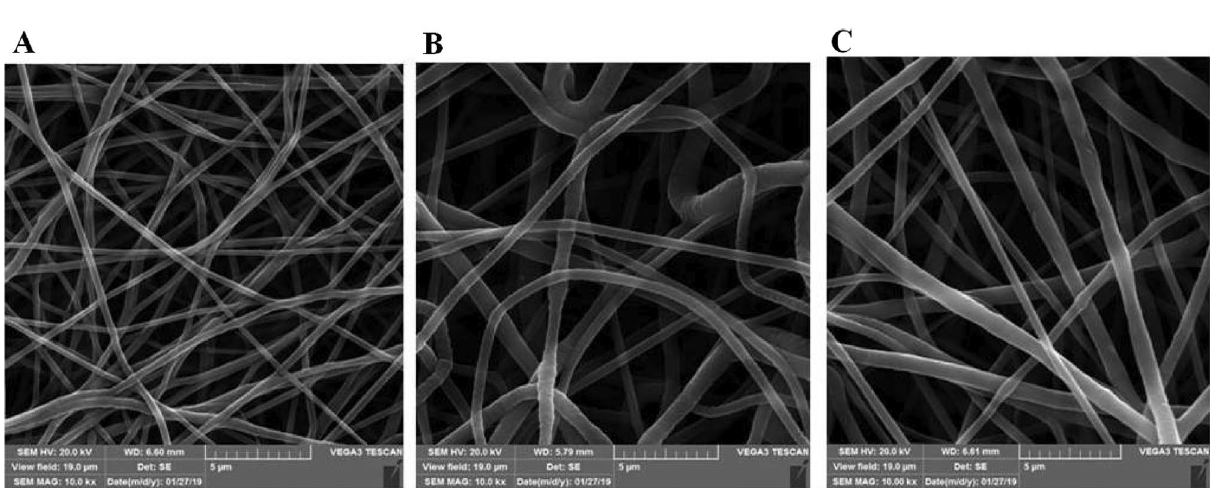
Figure 3. SEM image of different PCL nanofibrous mats obtained from ( A ) PCL 5%, fiber diameter of 254 ± 72 nm. ( B ) PCL 7.5%, fiber diameter 576 ± 238 nm, and ( C ) PCL 10%, fiber diameter 549 ± 217 nm. (Scale bars: 5